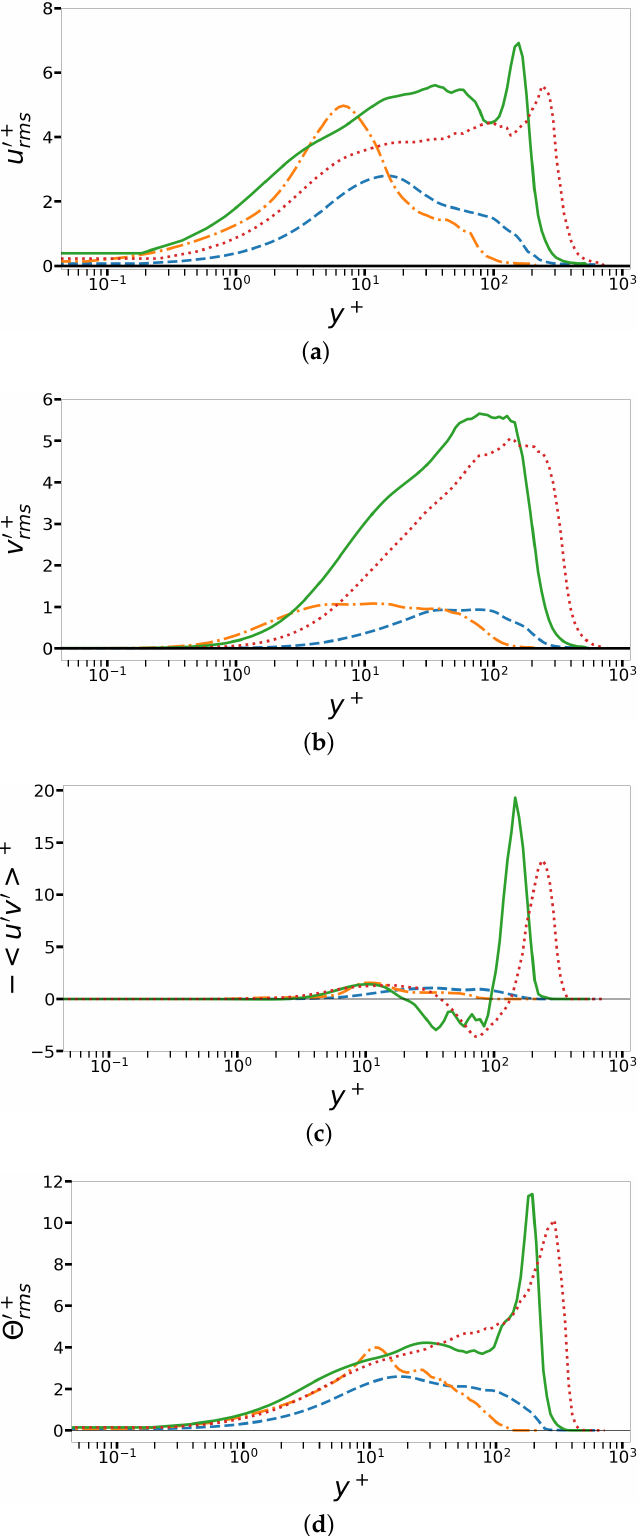
Figure 16. CASE 3: ( a ) RMS of streamwise velocity fluctuations, ( b ) RMS of wall-normal velocity fluctuations, ( c ) shear Reynolds stresses, and ( d ) RMS of thermal fluctuations (profiles as in the legend of Figure